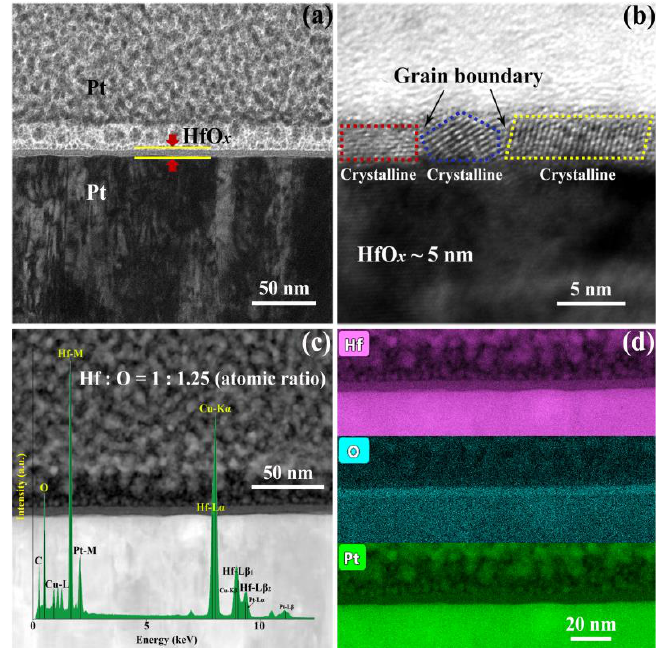
Figure 1. Cross-sectional ( a ) transmission electron microscope (TEM) image and ( b ) high-resolution transmission electron microscopy (HRTEM) image of the Pt/HfO x /Pt resistive switching (RS) device. ( c ) High-angle annular dark-field scanning transmission electron microscopy (HAADF STEM) image with energy-disperse spectra (EDS) analysis in the HfO x RS layer and ( d ) EDS mappings of the Hf, O and Pt distribution edges.